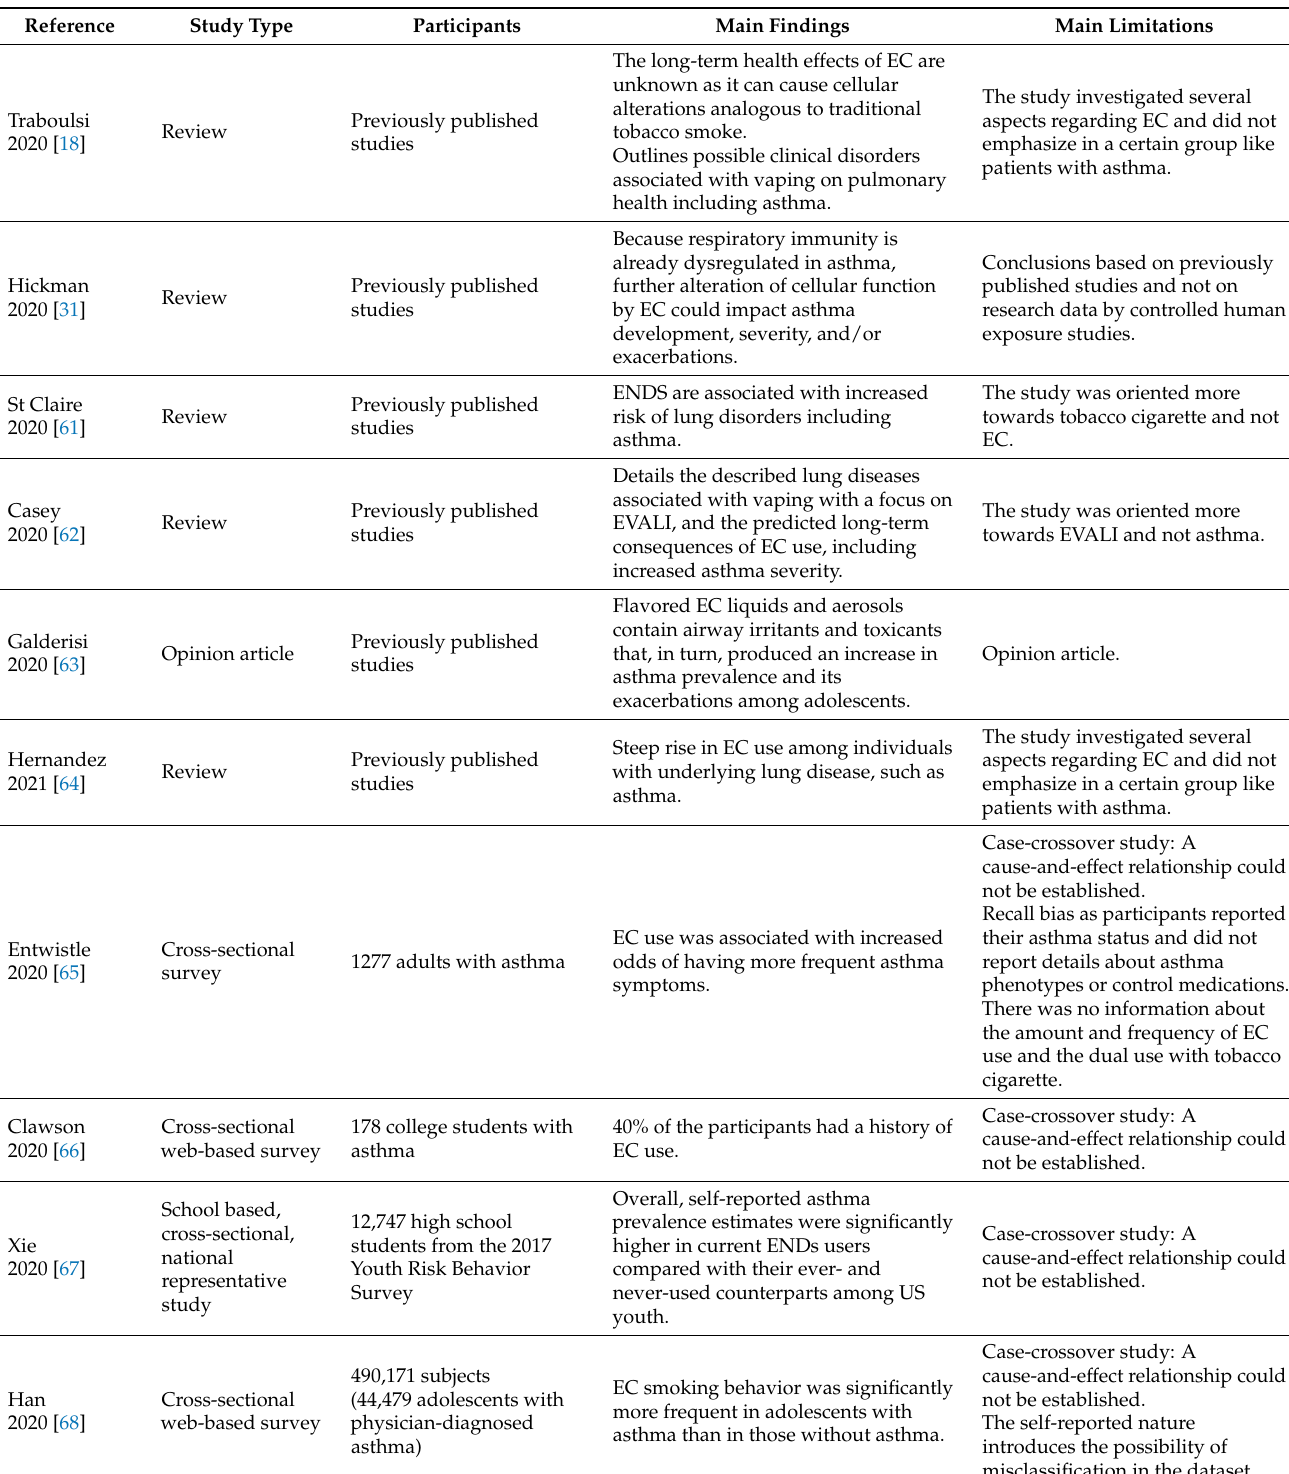
Table 2. Studies addressing research question 3: What is the effect of EC on the clinical characteristics of